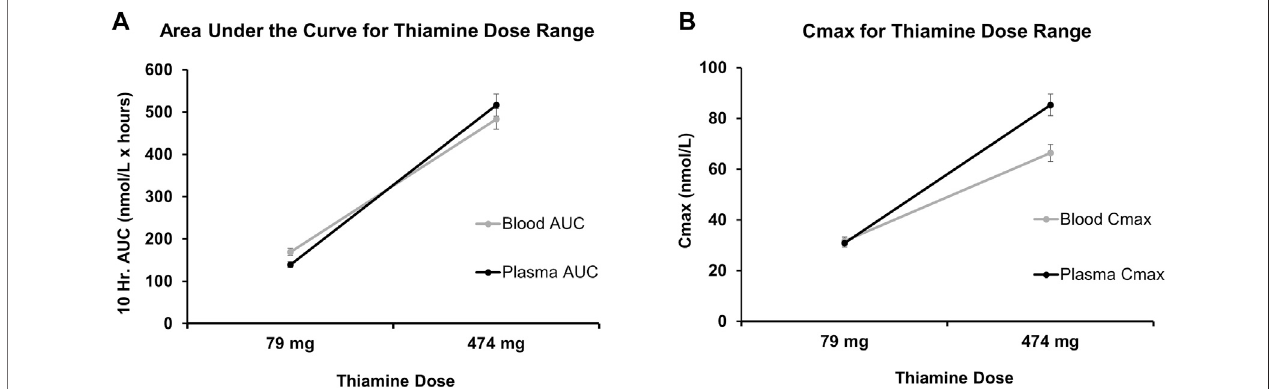
FIGURE3| Pharmacokineticsparametersoforalthiamineover10 h(Projected)inwholebloodandplasma. (A) PredictedcourseofAreaUndertheCurve(AUC)for lowvalues(79 mg/day) andhighvalues(474 mg/day)oftherangeoforalthiaminedoseinbloodandplasmaoverthe10 h. (B) Predictedmaximumconcentrationoflow values (79 mg/day) and high values (474 mg/day) of the range of oral thiamine dose in blood and plasma over the fi rst 10 h. Errors bars show a 5% variability in the pharmacokinetic measures at each dose.